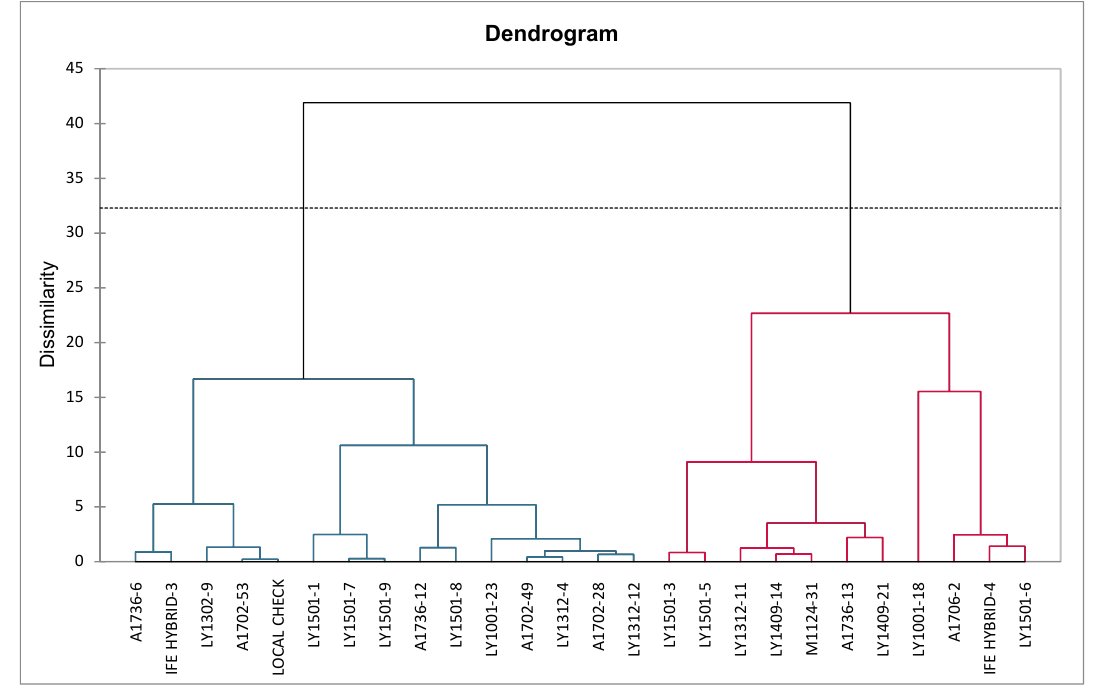
Figure 2. Dendrograms of maize genotypes.